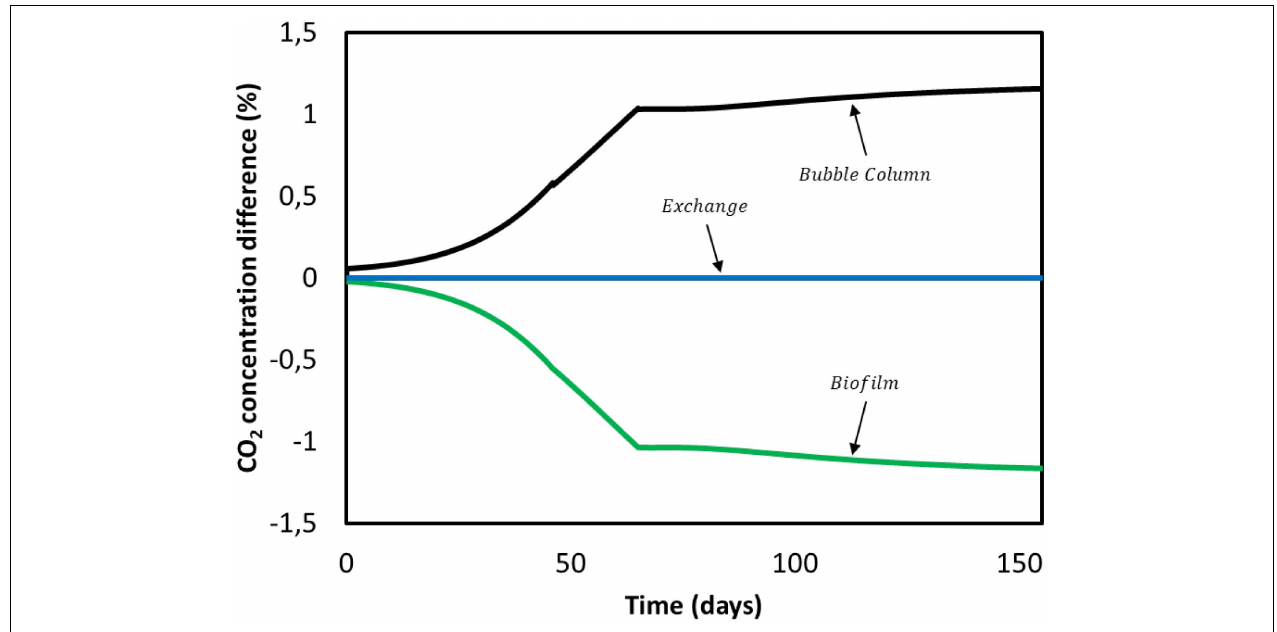
FIGURE 7 | CO 2 concentration difference between domains during Jourdin et al. (2019)